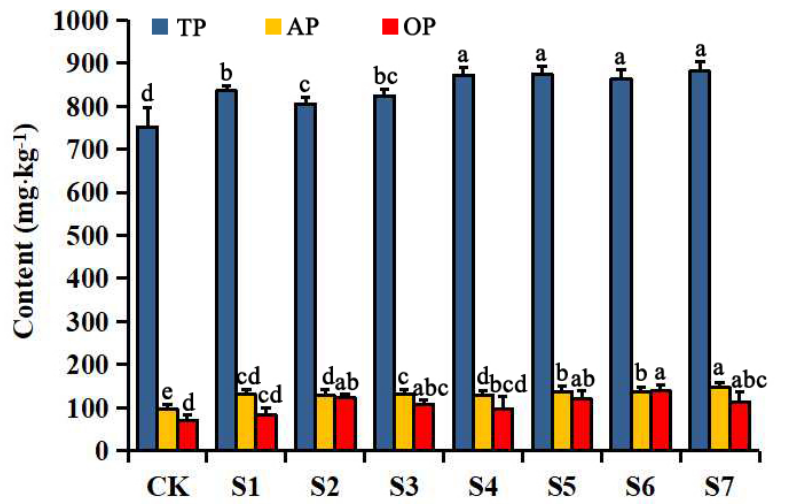
Figure 3. Total P (TP), Olsen-P (AP), and organic P (OP) concentrations in the rhizospheric soils of P. polyphylla var. yunnanensis . Data (means ± SD, n = 3) followed by different letters above the bars indicate significant ( p < 0.05) differences between treatments. Note: S1–S7 stand for Sample 1–Sample 7.